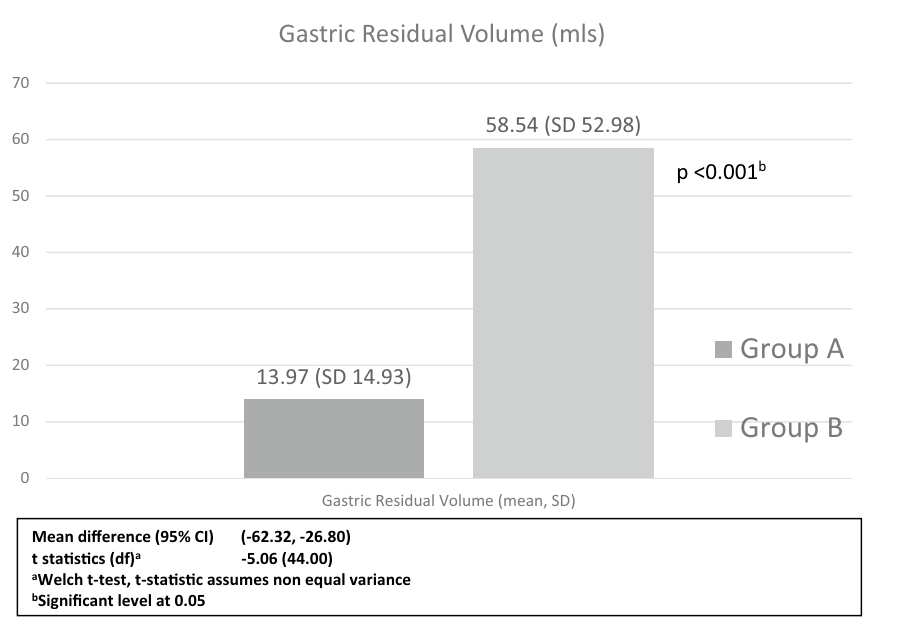
Figure 3. Comparison of gastric residual